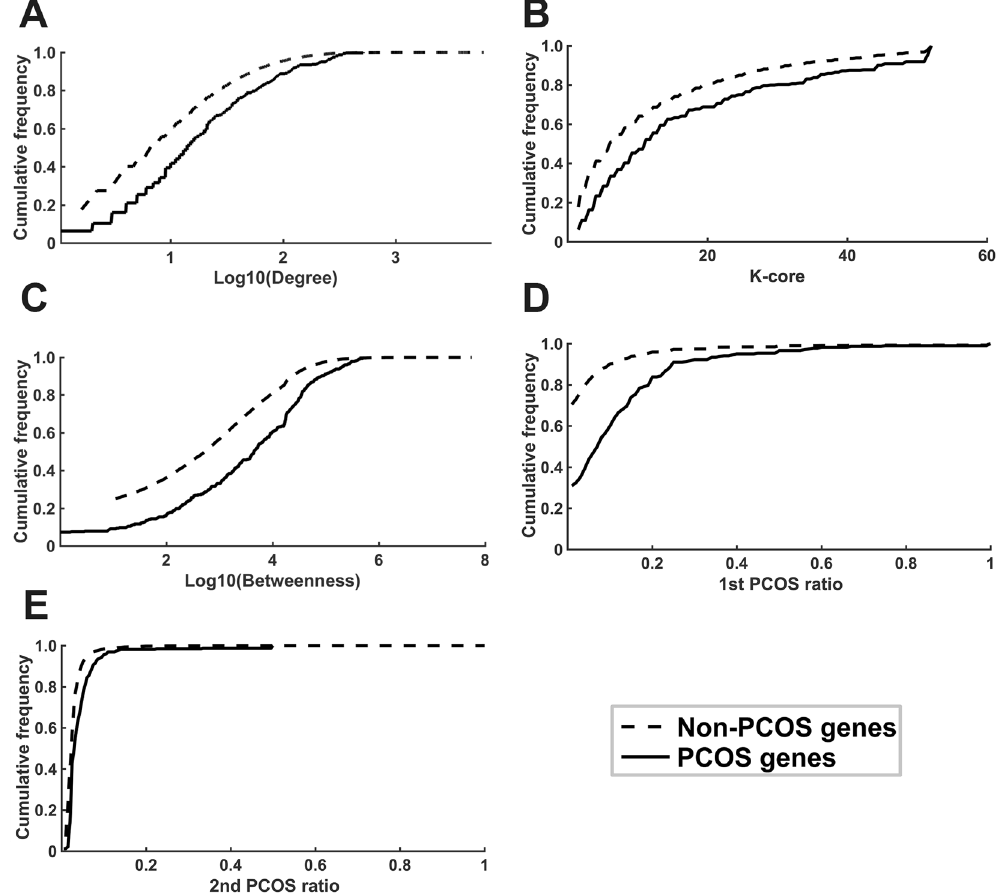
Figure 1. Cumulative frequency distributions of network features of PCOS genes and non-PCOS genes. The PCOS genes tend to have higher degree ( A ), K -core ( B ), betweenness ( C ), 1st PCOS ratio ( D ), and 2nd PCOS ratio ( E ) than that of non-PCOS genes. The cumulative frequency of different features is 100% for PCOS genes and non-PCOS genes. PCOS represents polycystic ovary